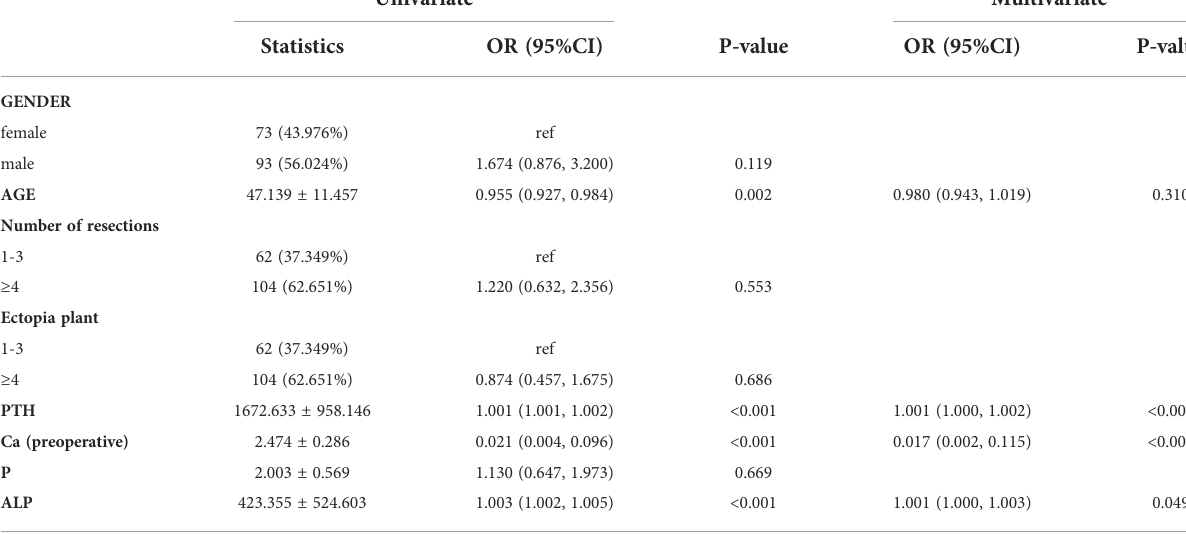
TABLE 2 Univariate and multivariate logistic regression